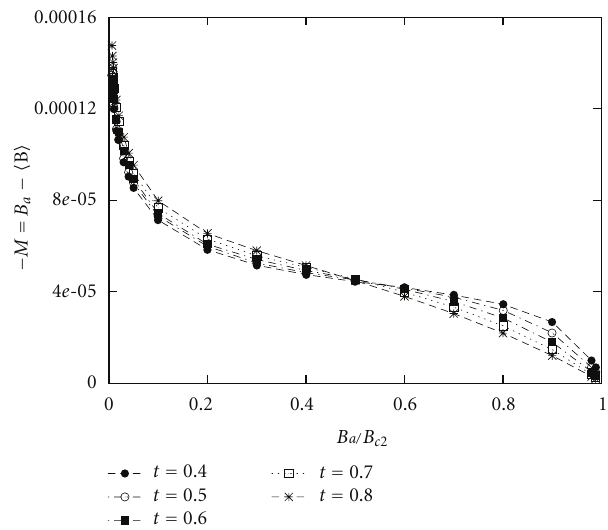
Figure 4: Applied magnetic field B a (measured in units of upper critical field B c 2 ) dependence of reversible magnetization calculated by the extended two-order parameter GL theory for di ff erent temperatures. Other parameters used in the calculation are GL parameter κ = 72 and mixed gradient coupling parameters (cid:2) v = 0 . 1 and β sd =